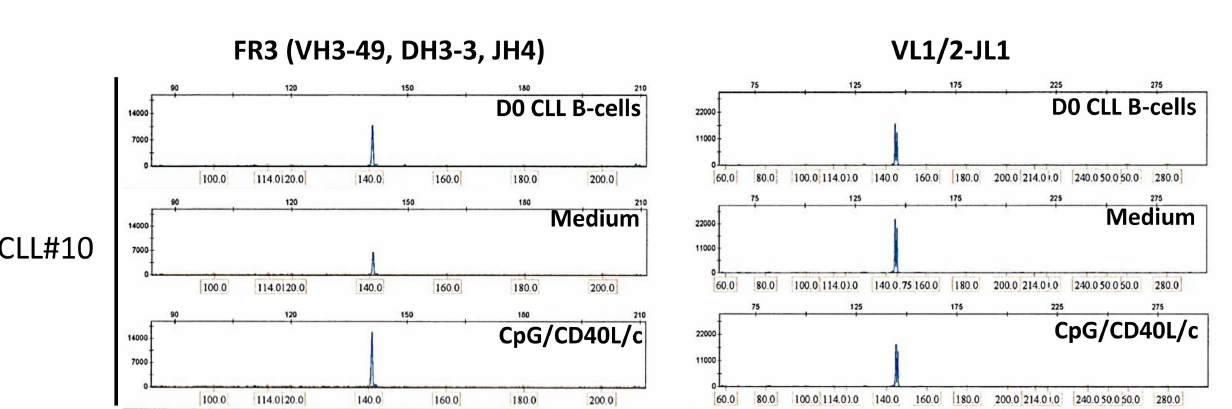
FIGURE 6 | GeneScan analysis of IgH and IgL gene rearrangements shows a monoclonal pattern at D0 and D7 . Fragments are aligned by size (indicated above and at the bottom of each panel). Left panels show a peak in the IgH framework 3 (FR3)-specific size range for D0 CLL B-cells (upper panel), D7 untreated-cells (Medium, middle panel), and D7 CpG/CD40L/ c-stimulated cells (lower panel), indicating a monoclonal rearrangement.